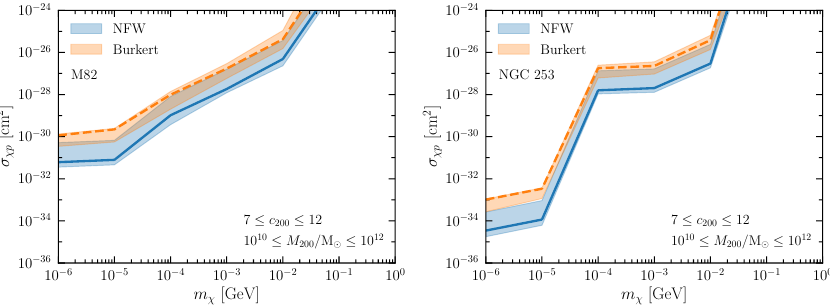
Figure 5. Left Panel σ χ p constrains as a function of m χ for M82. The blue band corresponds to the NFW profile, while the orange one corresponds to the Burkert one. Right Panel The corresponding constraints for NGC 253. Image taken from the supplementary material of Ref.